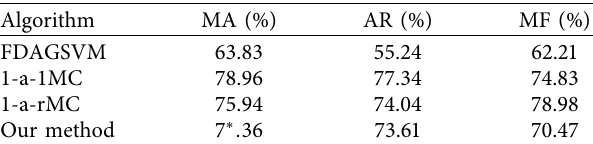
Table 3: Comparison of different algorithms.